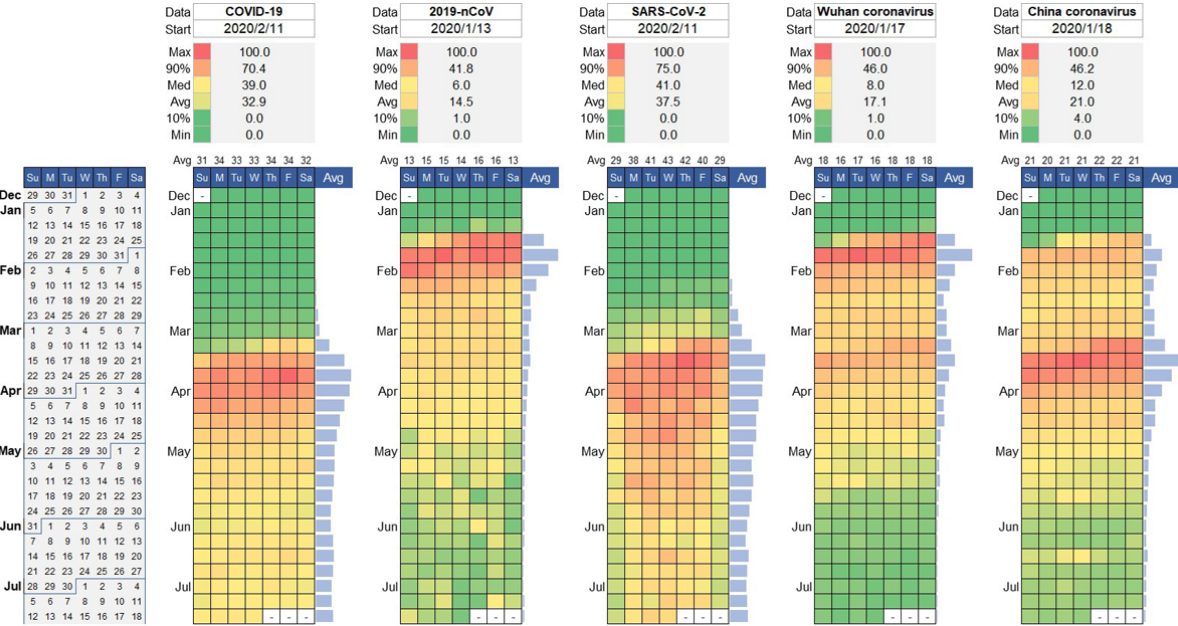
Figure 1. Calendar illustration on the relative search interest of the COVID-19 infodemic in the context of the COVID-19 epidemic (as of 15 July 2020; part